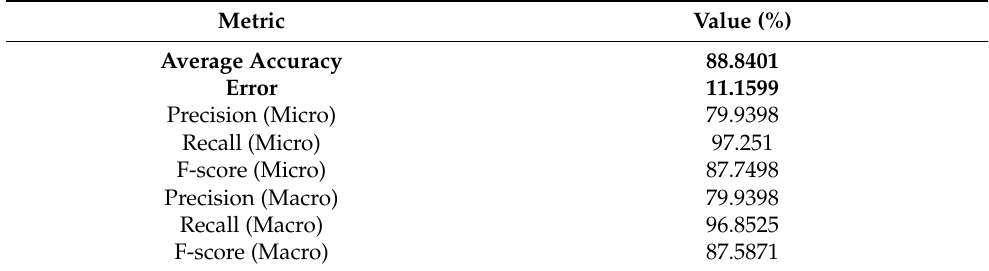
Table 20. Accuracy evaluation Results. The macro-accuracy and corresponding macro-error are in bold. Metric Value (%) Average Accuracy 88.8401 Error Precision (Micro) Recall (Micro) 97.251 F-score (Micro) 87.7498 Precision (Macro) 79.9398 Recall (Macro) 96.8525 F-score (Macro) 87.5871